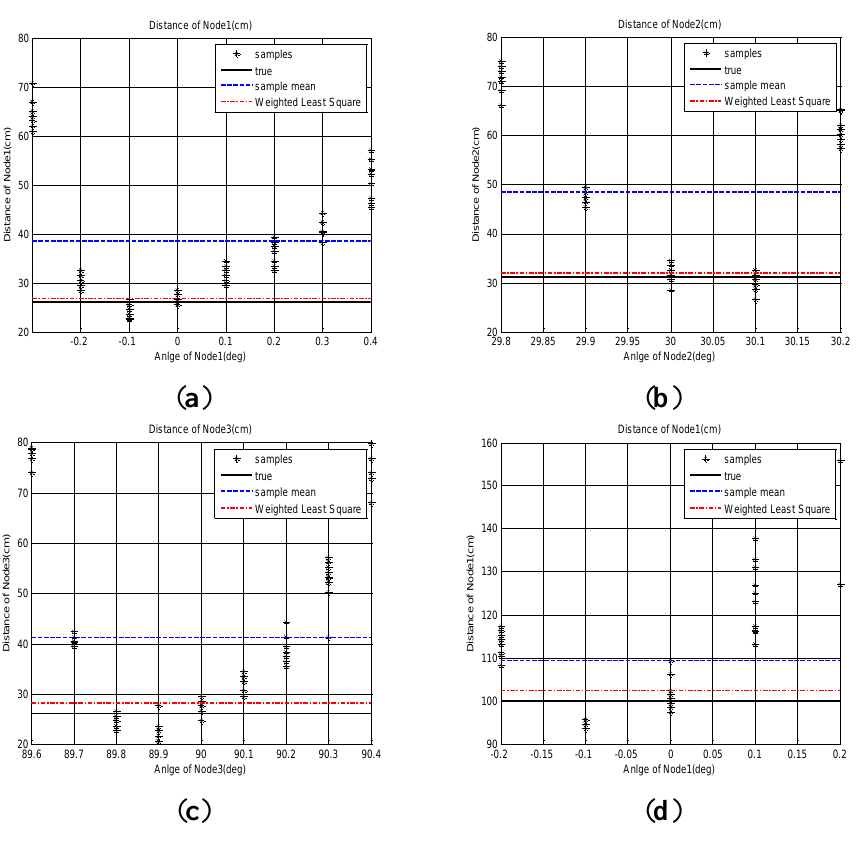
Figure 12. The performance comparison of the sensor node position estimation between the simple mean method and the weighted RLS method. ( a ) Node 1: (26 cm, 0 deg), ( b ) Node 2: (31.17 cm, 30 deg), ( c ) Node 3: (26 cm, 90 deg), ( d ) Node 1: (100 cm, 0